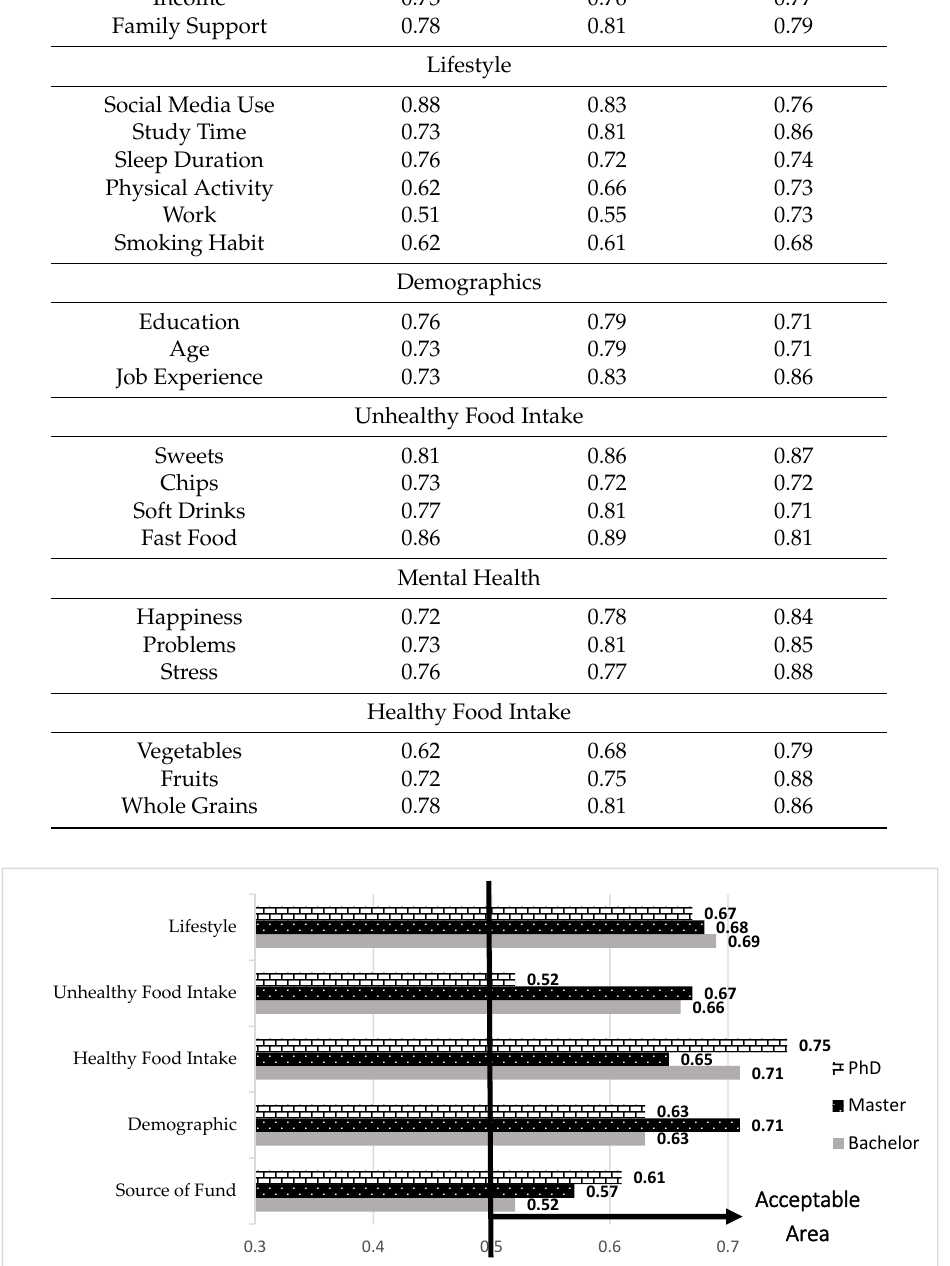
Table 5. Normality test based on the most significant indicators according to factor loading analysis. Indicators